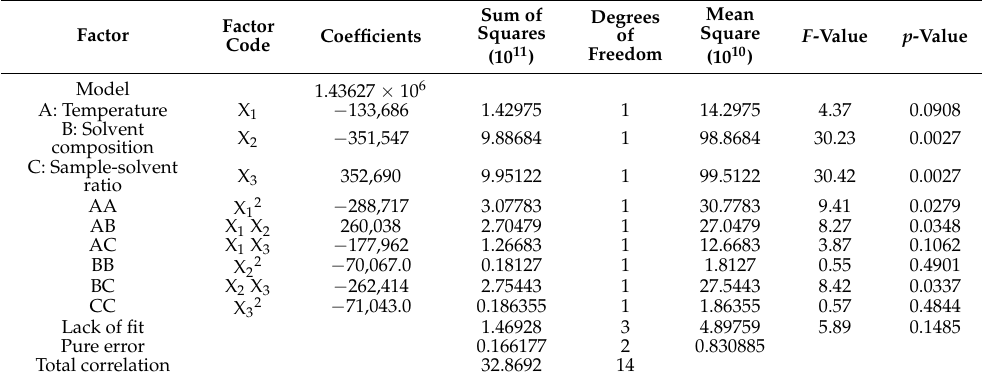
Table 2. Analysis of variance of the polynomic model adjusted to the extraction